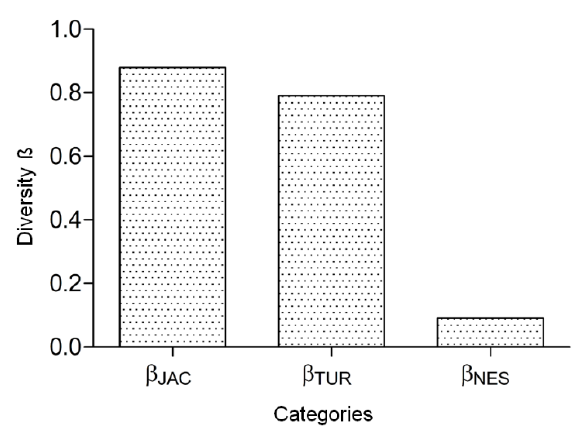
Figure 2. Mosquito beta diversity (ßJAC) and the partitioning of beta diversity into mechanisms of ecological turnover (ßJTU) and nestedness (ßJNE) among areas surveyed in the Caatinga biome between 2008 and 2014: MONA-GA — Grota do Angico Natural Monument in Sergipe; ESEC-RC — Raso da Catarina Ecological Station in Bahia; FLONA-Açu — Açu Natural Forest, ESEC-S — Seridó Ecological Station and SA — Sítio Areias in Rio Grande do Norte and NMG- North of Minas Gerais.